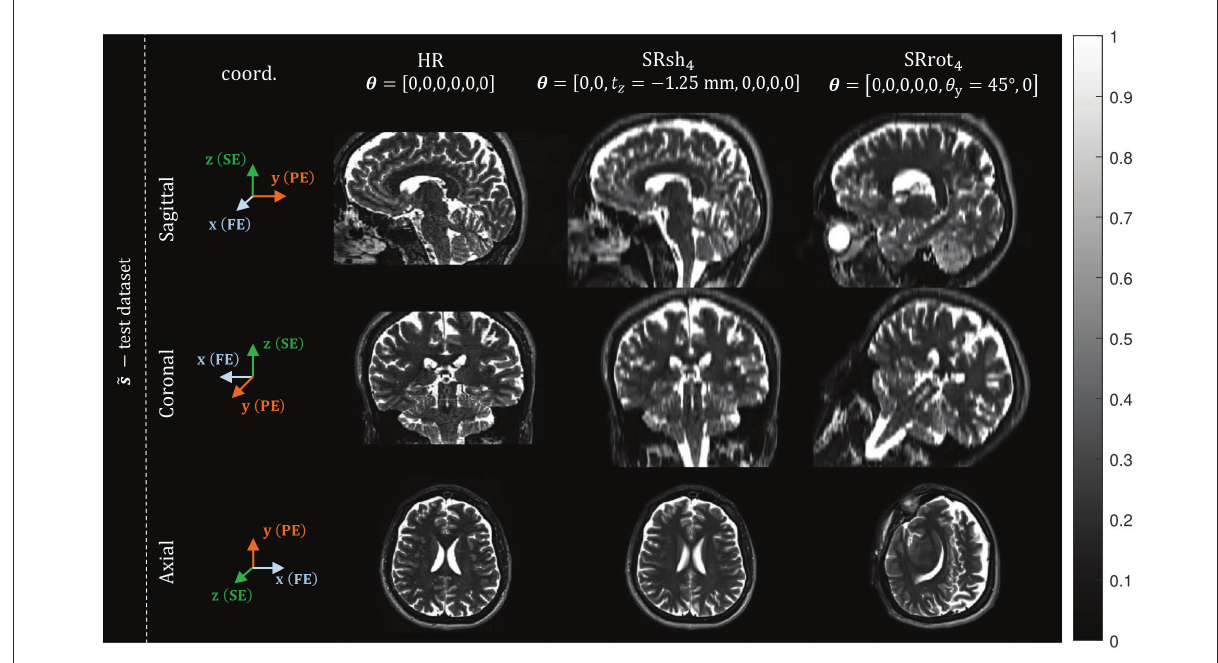
FIGURE2 Examples of intensity-normalized acquired MS images: views from orthogonal planes of one of the MS images from the test dataset, for each protocol. The MR image coordinate system is reported in the first column, where FE, PE, and SE, represent the frequency-encoding (x-axis), phase-encoding (y-axis), and slice-encoding (z-axis) directions, respectively. For each MS image, the corresponding rigid transformation parameter vector θ is shown.